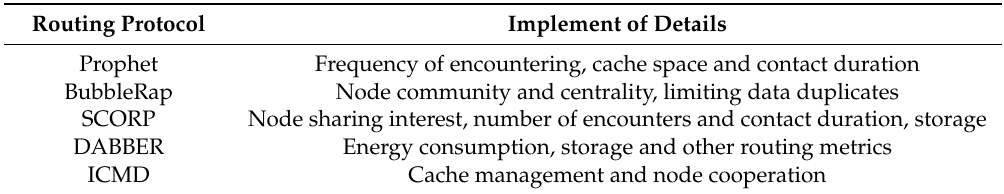
Table 1. The comparison of wireless opportunistic network routing